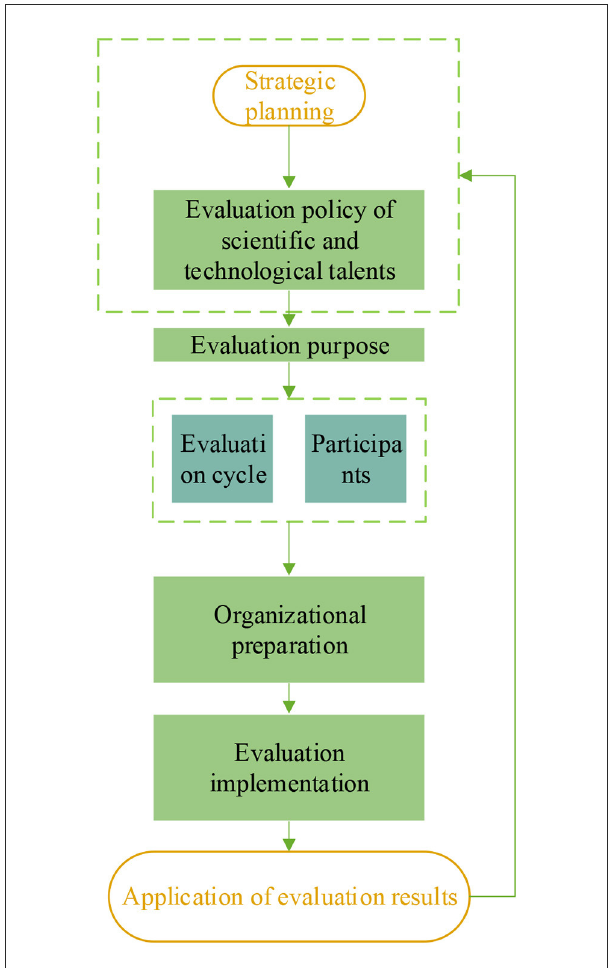
FIGURE2 The evaluation mechanism of the evaluation policy of S&T talents.